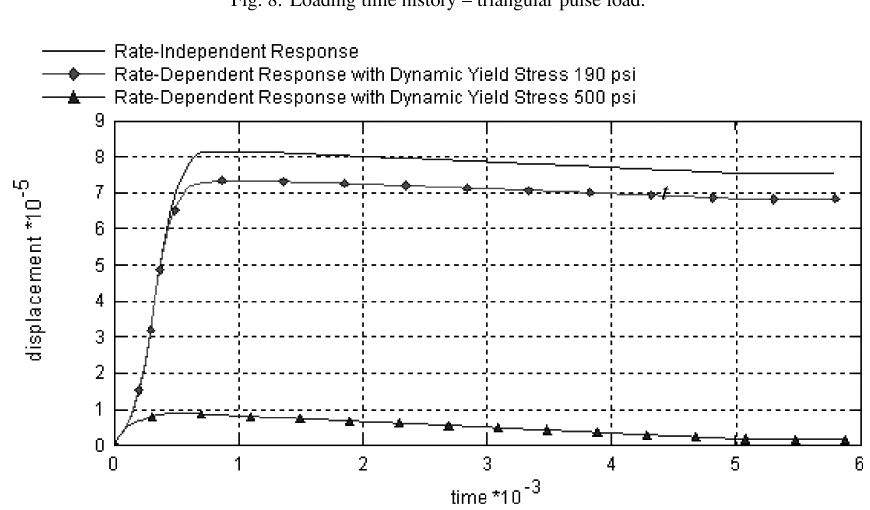
Fig. 9. Time histories of vertical displacement (units – [in]) at point A due to triangular pulse